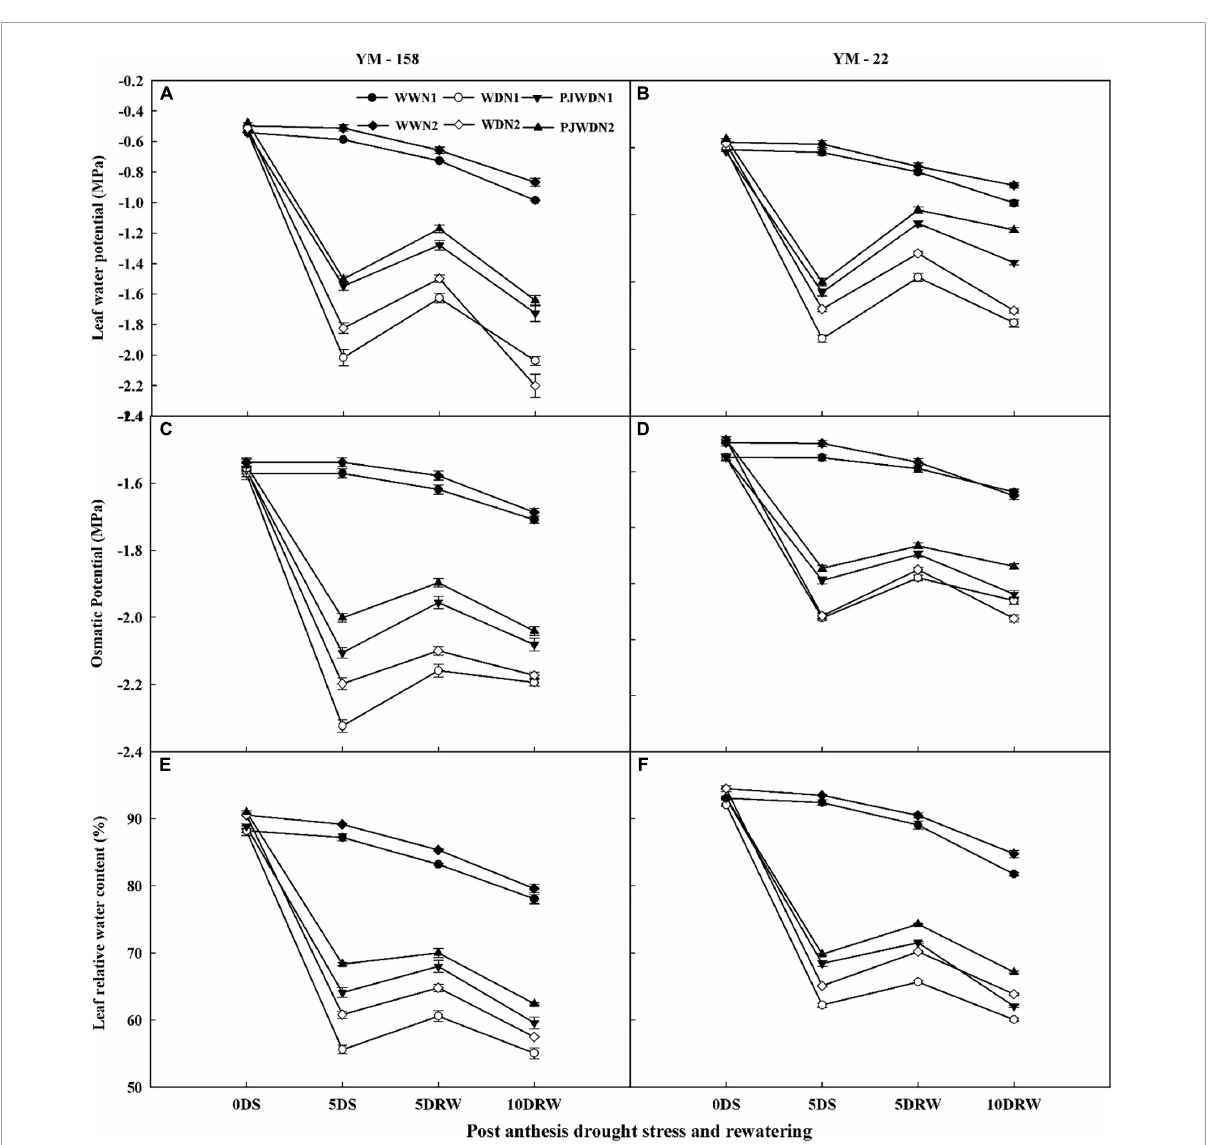
FIGURE2 Effects of pre-drought priming on leaf water potential ( (cid:57) w), osmatic potential ( (cid:57) s), and leaf relative water content (LRWC) in response to post-anthesis drought stress under two nitrogen (N) rates (N1,180 and N2,300) in Yangmai-158 (A,C,E) and Yangmai-22 (B,D,F) wheat cultivars. Treatments: WW (control), no priming at jointing + no post-anthesis drought stress; PJWD, priming at jointing + post-anthesis drought stress; and WD, no priming at jointing + post-anthesis drought stress. Pre-drought priming was completed during the jointing stage, and post-anthesis drought stress was applied from 7 to 14 DAA. The horizontal axis shows the time course of the sampling: 1 day before drought stress (0DS), 5 days after drought stress (5DS), 5 and 10 days after re-watering (5DRW and 10DRW). Each vertical bar above the mean values indicates